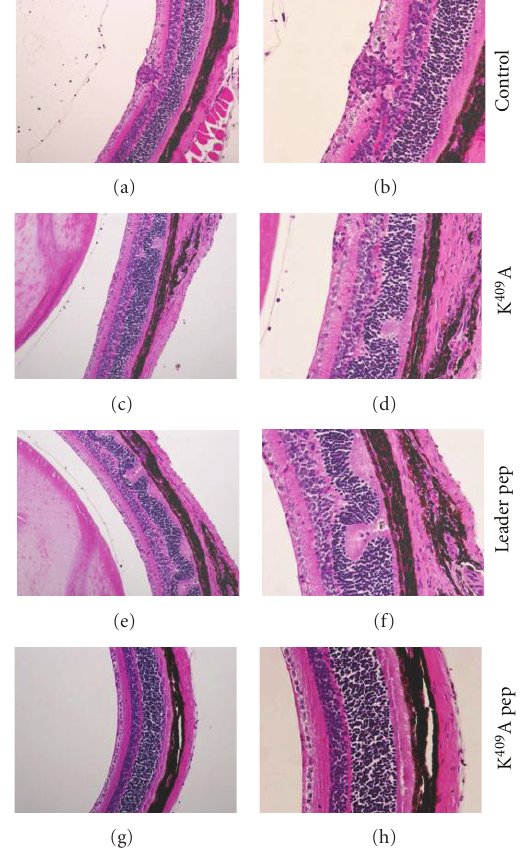
Figure 2: Histopathologic features representative of the EAU scores. Mice control shows ocular lesions characterized by cells infiltrating the vitreous and vasculitis (a) and (b); in mice injected with K 409 A, it is possible to observe inflammatory cells in the vitreous and retinal folds (c) and (d); mice injected with Leader pep show cells in the vitreous and retinal folds (e) and (f); mice injected with K 409 A pep exhibit a normal retinal architecture corresponding to nonimmunized na¨ıve mice (g) and (h). Representative photographs (hematoxylin-eosin staining). Original magnifications: 100 × (left); 400 ×